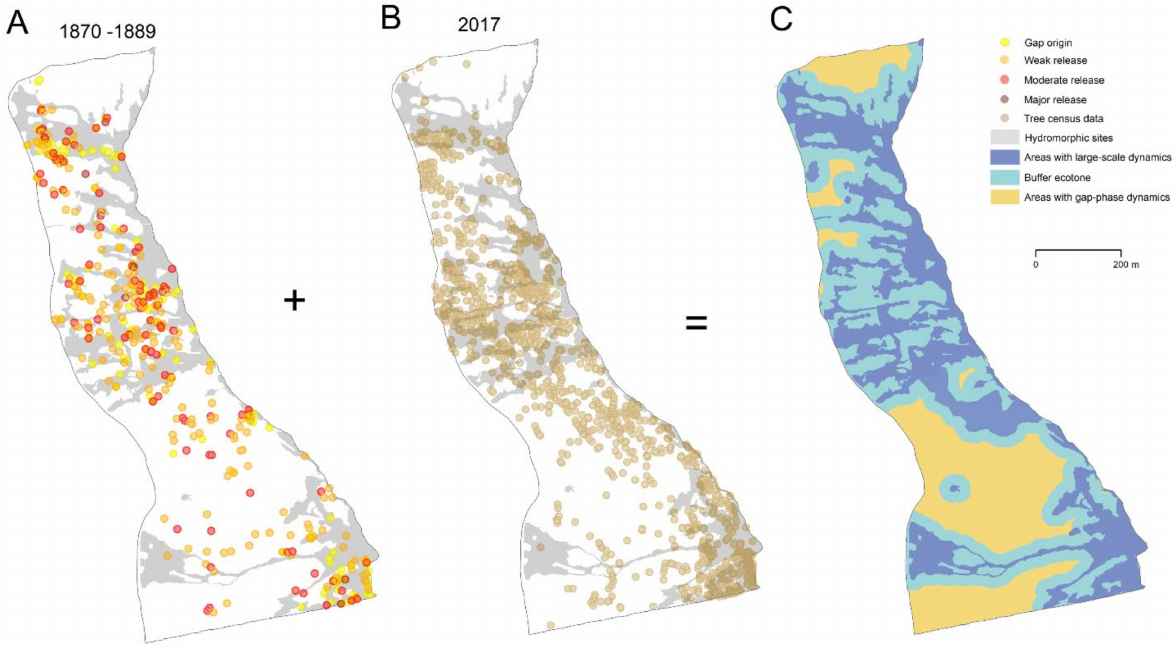
Figure 4. Maps of the spatial pattern of severe disturbances in Boubin, based on dendrochronological ( A ) and tree census ( B ) data and a map of the spatially-explicit mixed disturbance regime ( C ), derived on the basis of the soil hydromorphism map plus dendrochronological and tree census